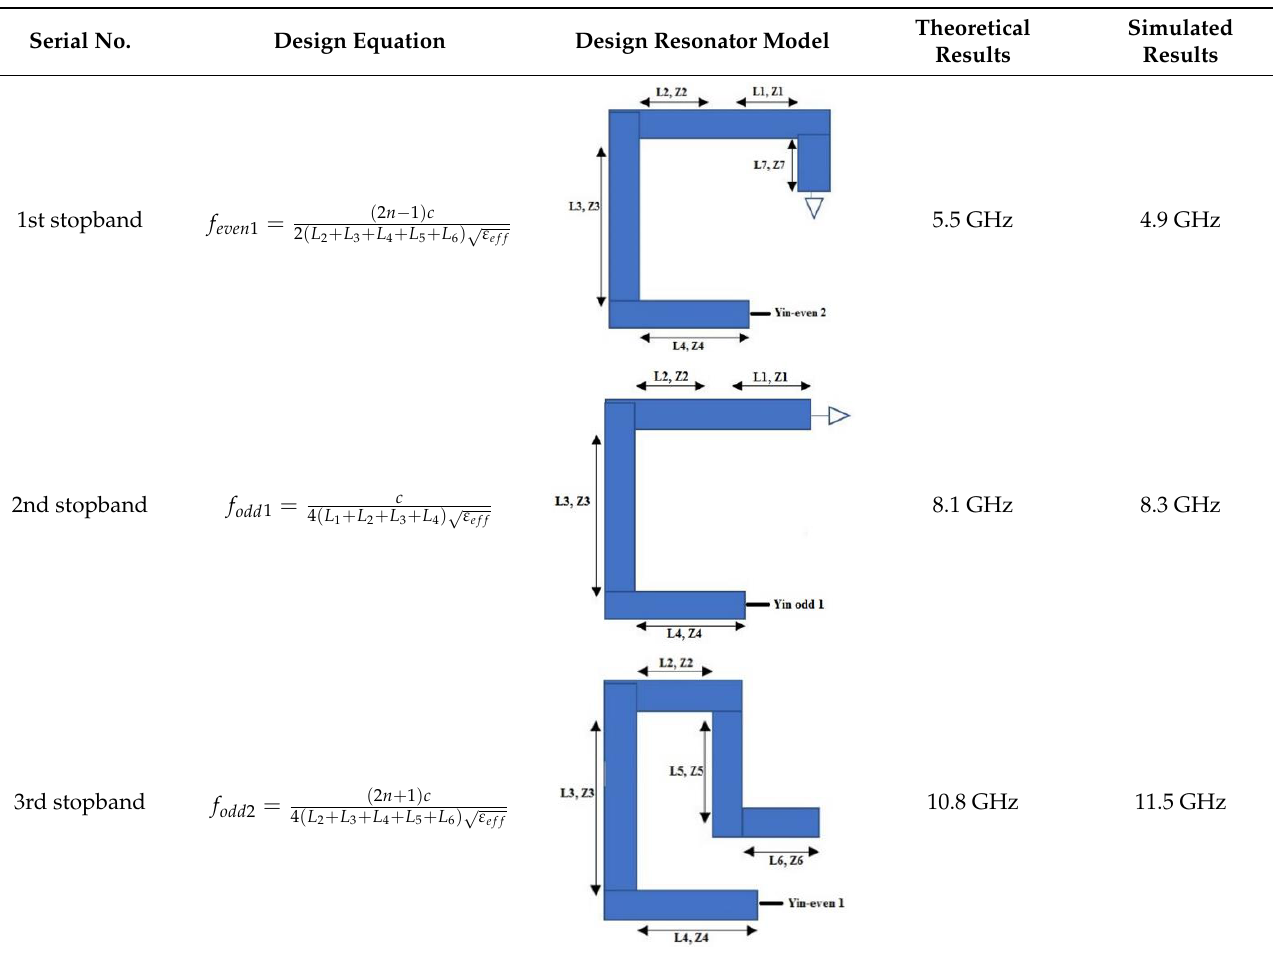
Table 2. Design table for finding the stopbands of the proposed filter. Serial No.